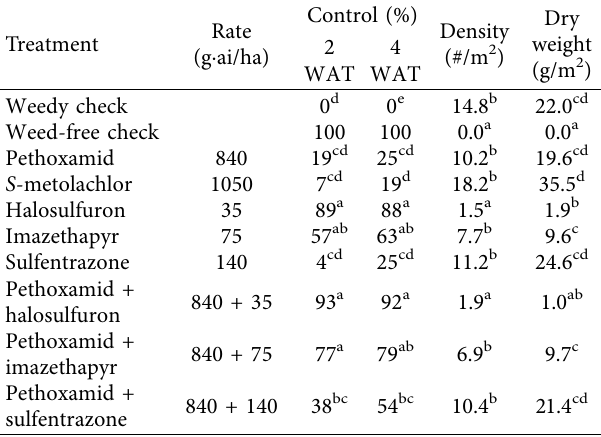
Table 4: Percent control, density, and dry weight of lambsquarters 2 and 4 weeks after herbicide treatment (WAT) in white bean treated with pethoxamid applied PRE in 2015, 2016, and 2017.